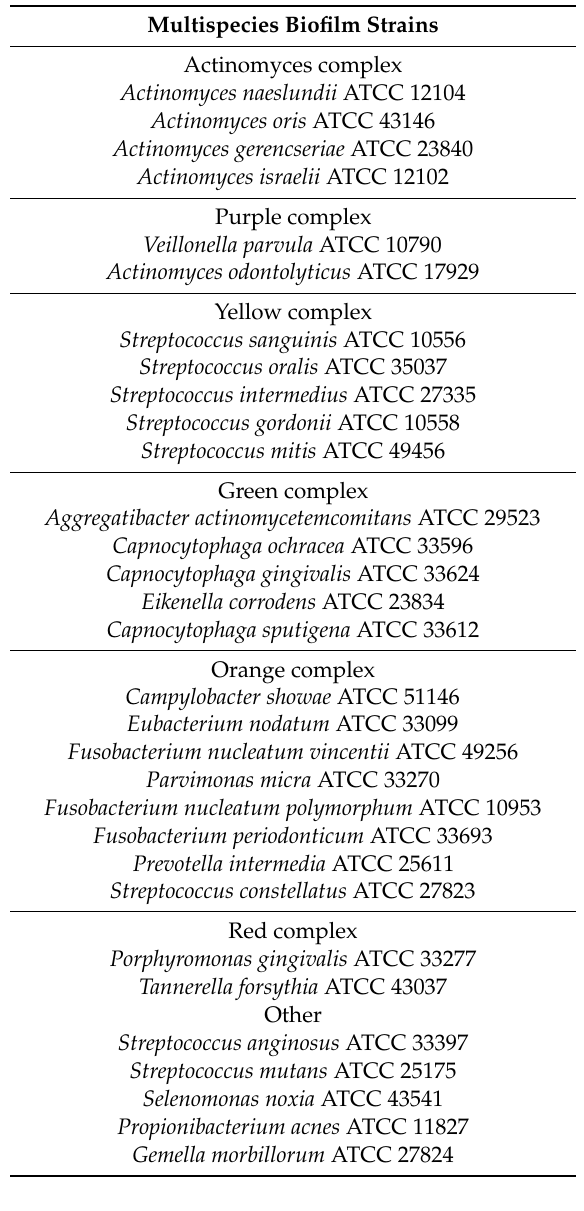
Table 1. List of bacterial species cultured in multispecies biofilms. The strains were categorized into the microbial complexes described by Socransky et al.